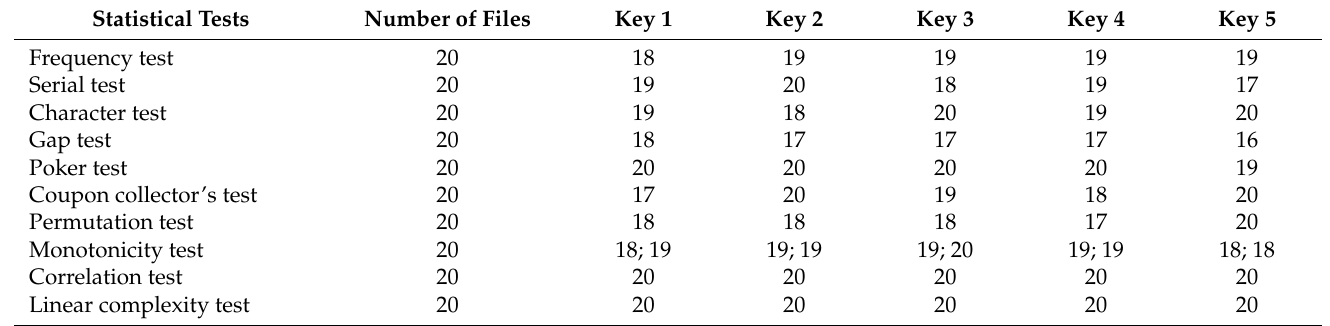
Table 6. The results of the statistical tests for different keys with a probability value of 0.5.